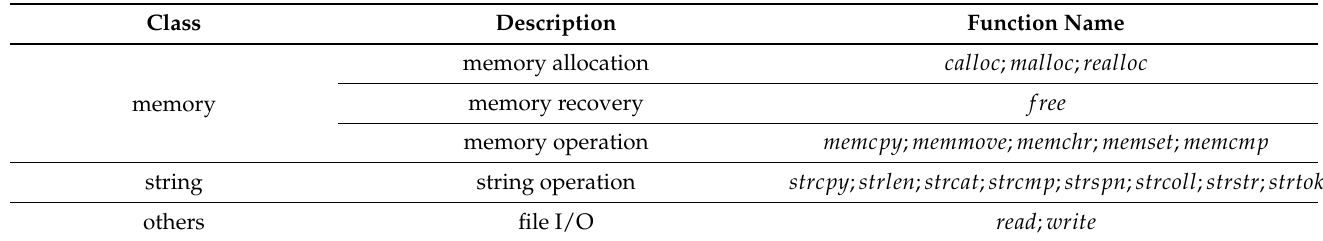
Table 1. Dangerous